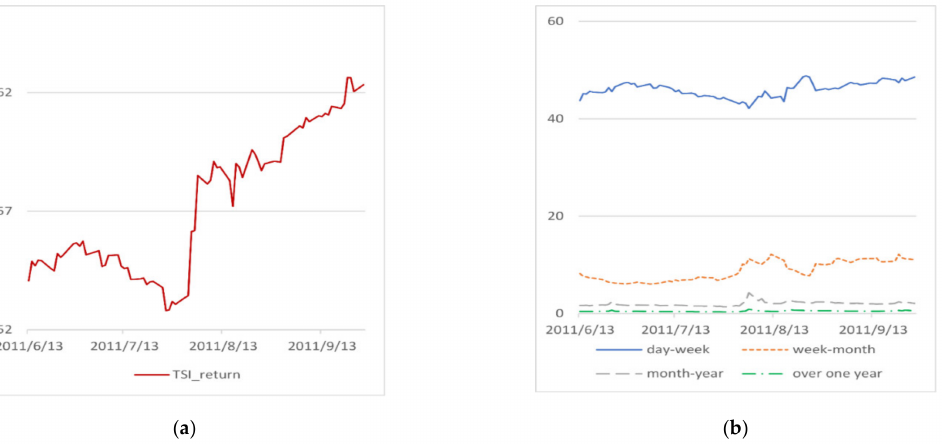
Figure 4. Total spillover of the price return system during the European debt crisis. ( a ) total return spillover. ( b ) frequency decomposition of return spillover.